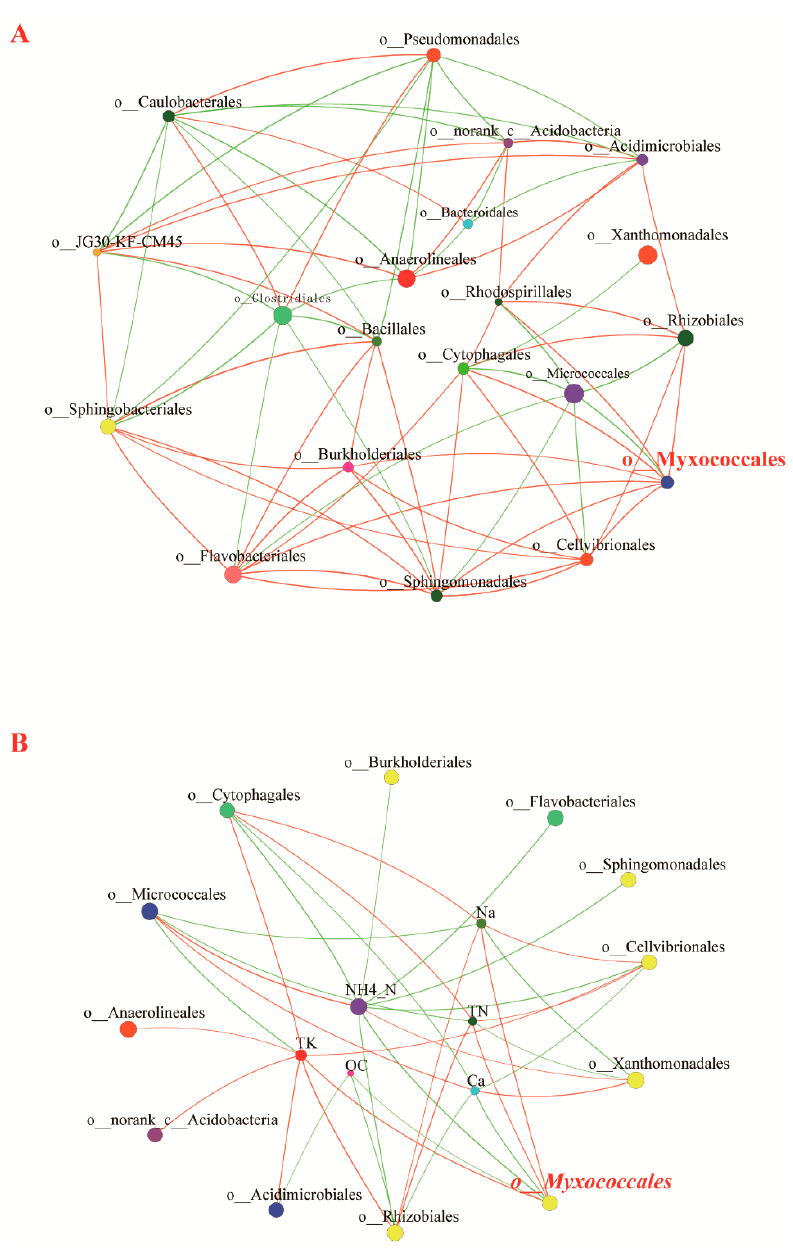
Figure 6. Distribution of predatory myxobacteria in different compost manures. Single ( A ) and two-factor ( B ) correlation network analysis at the order level. A network graph was constructed to illustrate a positive or negative correlation between different bacterial orders. A red link indicates a positive correlation between two individual nodes, whereas a green link indicates a negative correlation. Different nodes represent different bacteria orders or environmental factors. TN: total nitrogen, OC: organic carbon, TK: total potassium, NH 4+ -N: ammonium nitrogen.